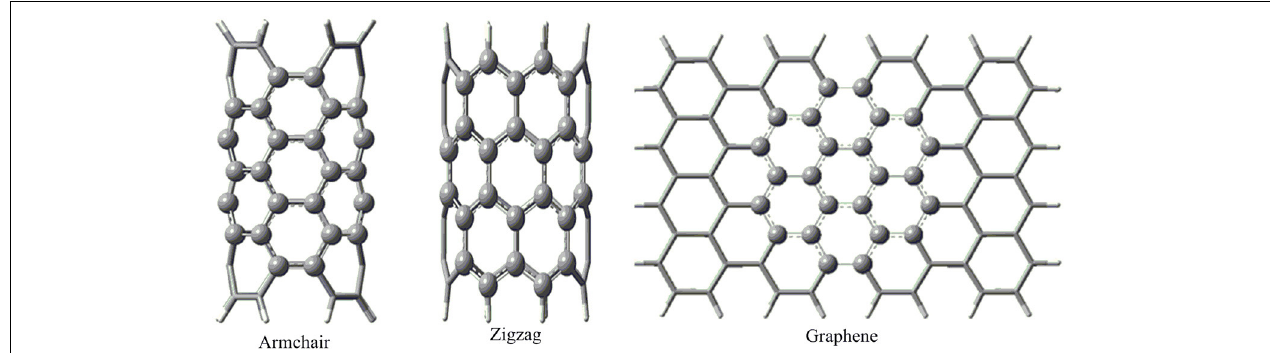
FIGURE 1 | The atoms shown by the ball-and-stick model were considered for the higher layer and the rest of the atoms shown by the tube model were considered for the lower layer in the ONIOM